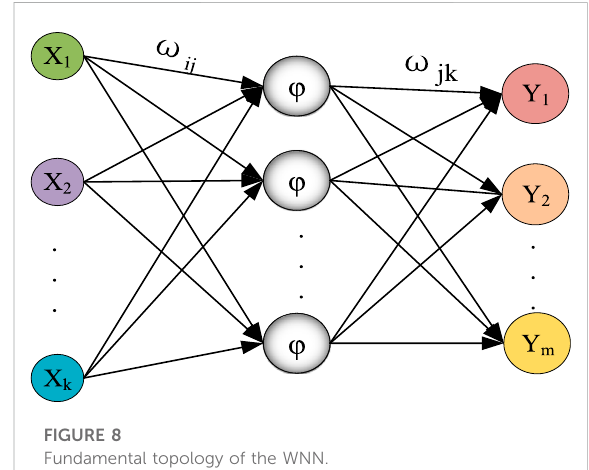
FIGURE 8 Fundamental topology of the